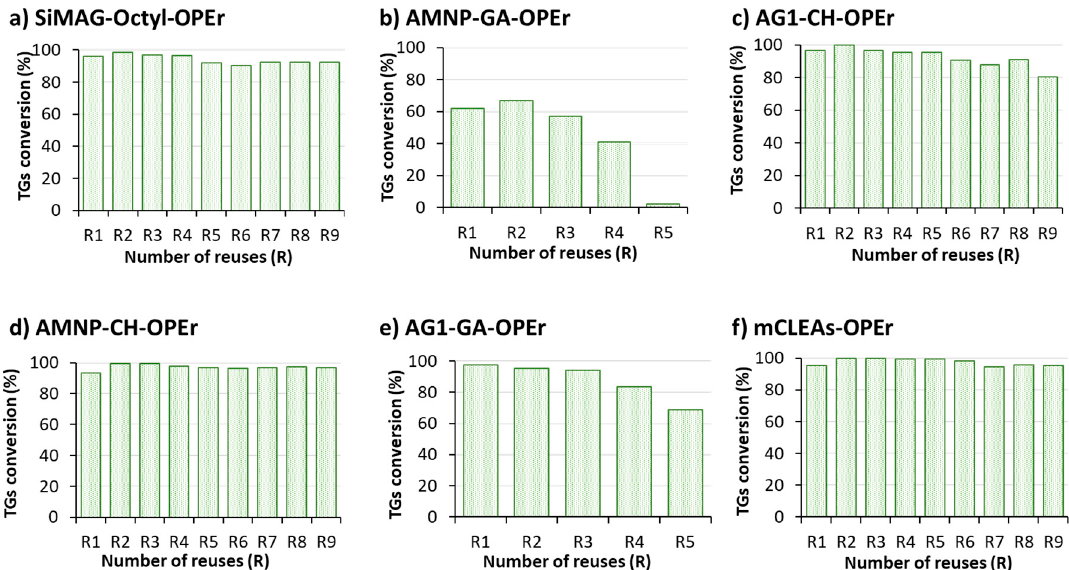
Figure 4. Operational stability of OPEr nanobiocatalysts in nine consecutive 24 h transesterification cycles of cooking oil wastes and methanol. ( a ) SiMAG-octyl-OPEr; ( b ) AMNP-GA-OPEr; ( c ) AG1-CH-OPEr; ( d ) AMNP-CH-OPEr; ( e ) AG1-GA-OPEr; ( f ) mCLEAs-OPEr. The reactions were developed at 25 °C, with a rotational stirring (100 rpm), an oil:methanol ratio of 1:4, and 100 mg of each nanobiocatalyst.